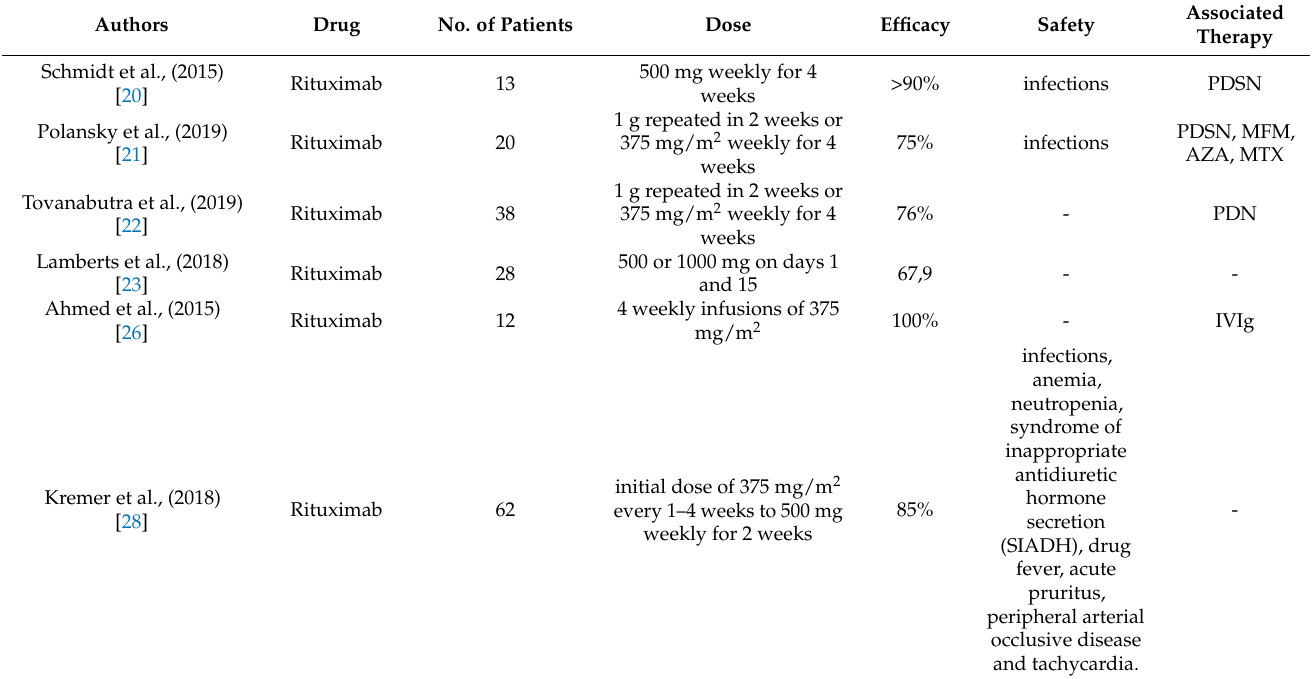
Table 1. Studies summarizing rituximab use in